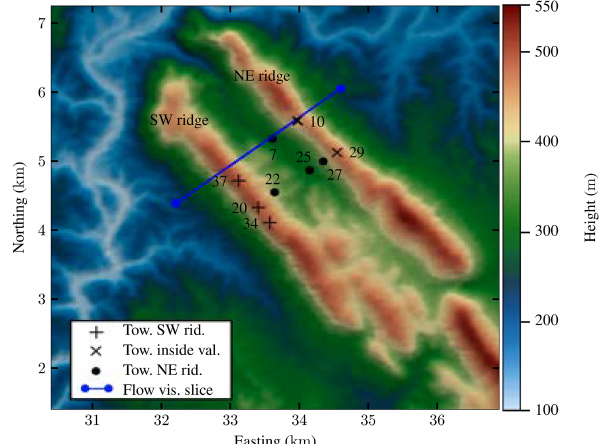
Figure 4. Computational grid structure, partial view from the side. The mesh used in this study consists of about 88 million cells, while the mesh presented in this figure is far coarser (about 10 million) for illustration